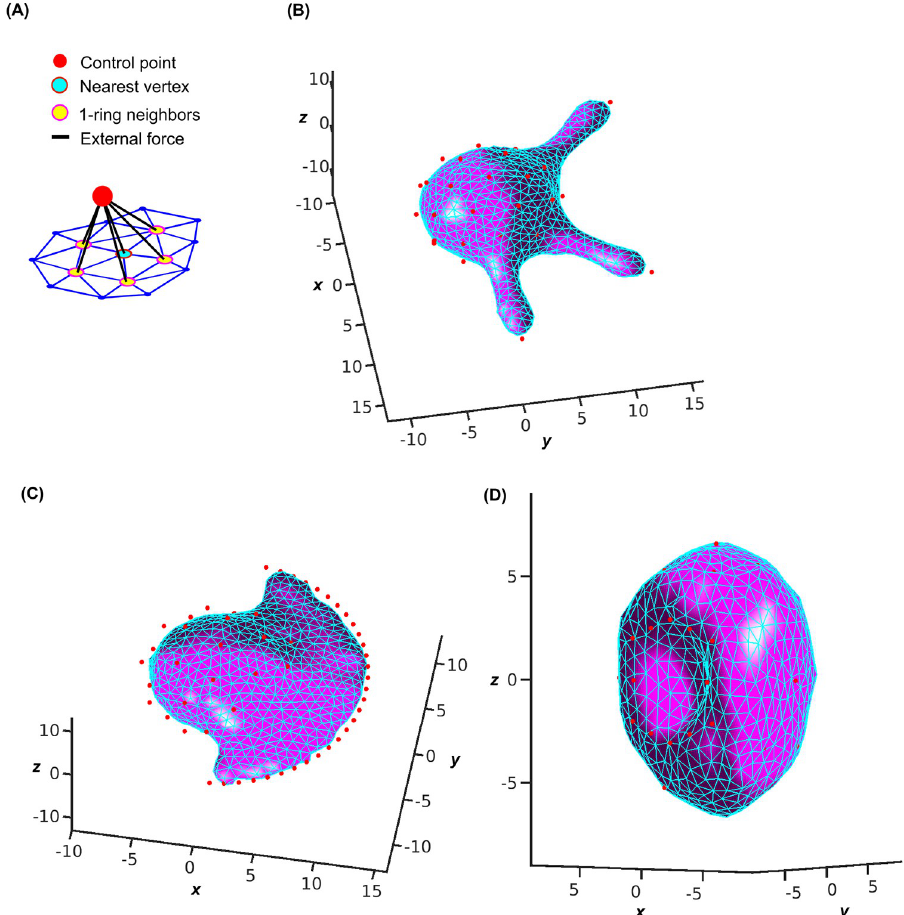
Fig 4. Applications of the proposed method to generate high-quality meshes of salient geometries under external forces. (A) Definition of external control points attracting the nearest mesh vertex i and i ’s 1-ring neighbors nb ( i ). (B) Formation of a filopodium by placement of a control point at the tip and control points holding the remainder of the globular cell in place. (C) Formation of a lamellipodium by placement of control points in a circular rim and control points holding the remainder of the globular cell in place. (D) Formation of an invagination by placement of a control point 1/3 into the globular cell and control points holding the remainder of the cell in place. Matching videos are provided in S4–S6 Videos (2 × 10 4